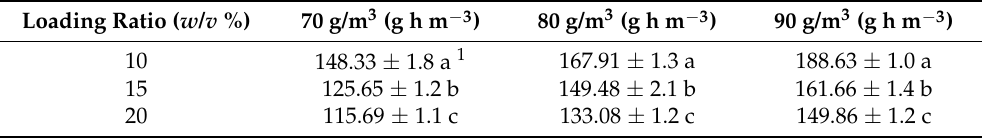
Table 2. The Ct product of EF at various dosages depending on the loading ratios of grapes (10, 15, 20%).